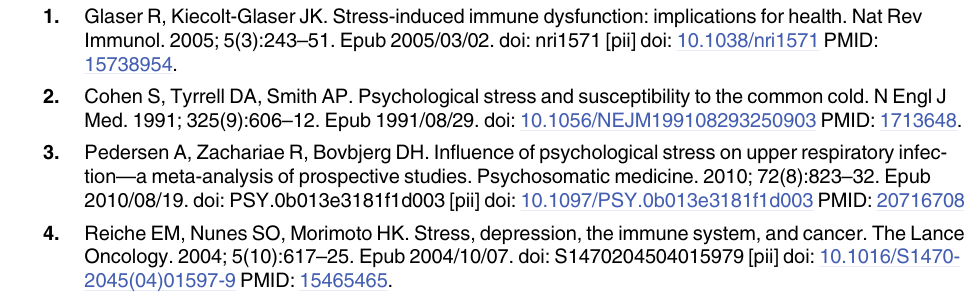
S2 Fig. Gating strategy to define lymphocyte and NK cell subsets and to assess NKG2D expression and IFN γ and CD107a production in NK cell subsets. The top row shows the gat- ing in order to distinguish B cells, CD4+ and CD8+ T cells. A second panel was used to detect NK cells, further subdividing them into CD56 dim and CD56 bright NK cells and analyzing IFN γ and CD107a production ( 2 , middle row, data is shown for CD56 dim). A third panel was designed to detect NKG2D expression ( 3 , CD314, bottom middle) and a last one to stain for the glucocorticoid receptor ( 4 , bottom right) on NK subsets. In grey, full stainings are shown whereas in white, an FMO staining is depicted for NKG2D and an isotype control for GCR. All data was acquired on an Accuri C6 (Becton Dickinson). S3 Fig. Gating strategy for the analysis of adhesion and hormone receptor expression on NK cell subsets. NK cells were defined by CD16 and CD56 expression on single, live CD3- cells (upper row). The first panel stained for ADRB2 and CD62L on NK cell subsets whereas the second panel stained for CX3CR1 and CD18. Example stainings on CD56dim NK cells are shown in dark grey while isotype control (ADRB2) or fluorescence minus one controls (FMO, for CD62L, CX3CR1 and CD18) are shown in light grey. All data was acquired on an LSRFor- tessa flow cytometer (Becton Dickinson). S1 Protocol. Detailed RT-PCR protocol for the hormone receptor analysis incl. a complete list of the primers